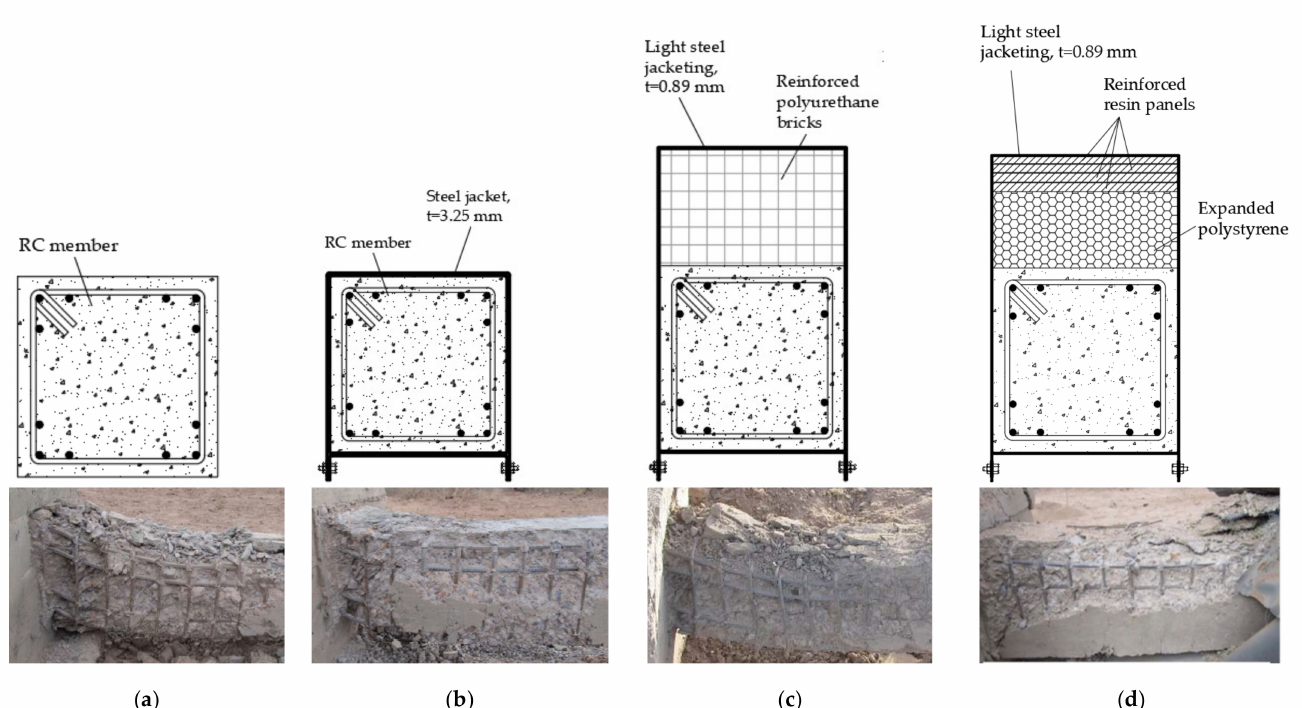
Figure 14. Damage after blast load on RC members: ( a ) without protection; ( b ) with steel jacketing; ( c ) with polyurethane bricks, and ( d ) with reinforced resin panels [15,16,22]. Copyright permission obtained from